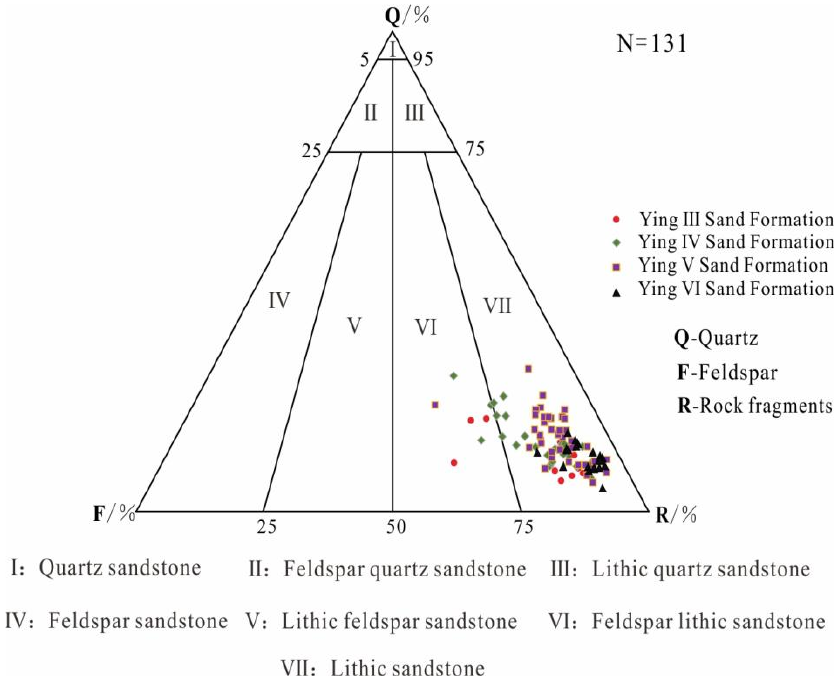
Figure 5. Lithological triangulation of tight clastic reservoirs in the study area. Table 2. Parameters for microscopic pore structures drawn from the